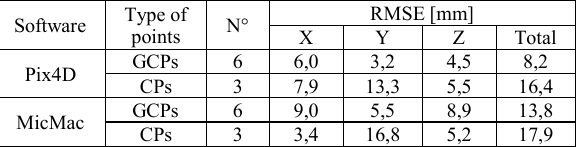
Table 3. Comparison of the mean errors in the three coordinate